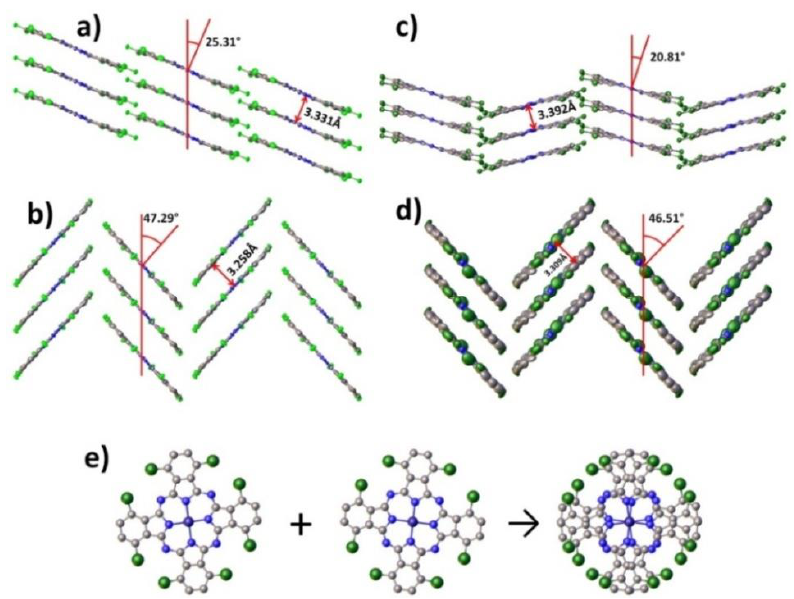
Figure 3. Molecule packing diagrams for ZnPcF 4 -p ( a ), ZnPcF 4 -np ( b ), ZnPcCl 4 -p ( c ), ZnPcCl4-np ( d ); disorder of ZnPcCl4-np molecules ( e ).